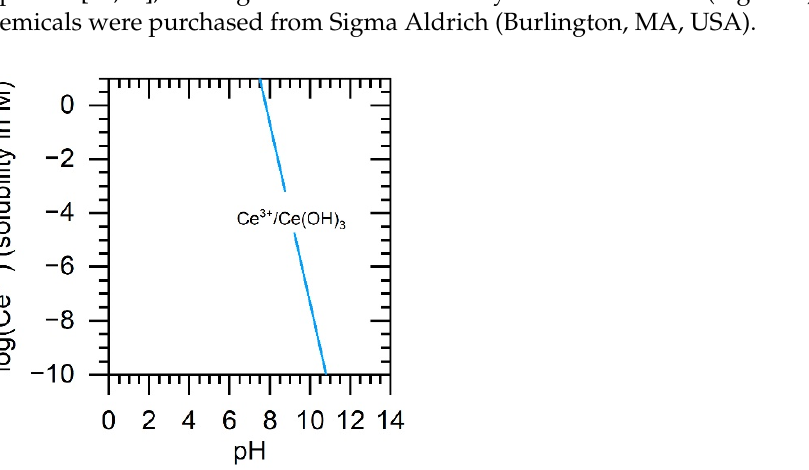
Figure 2. Equilibrium curves for Ce 3+ /Ce(OH) 3 as a function of the solution pH. The image is reproduced from [55].